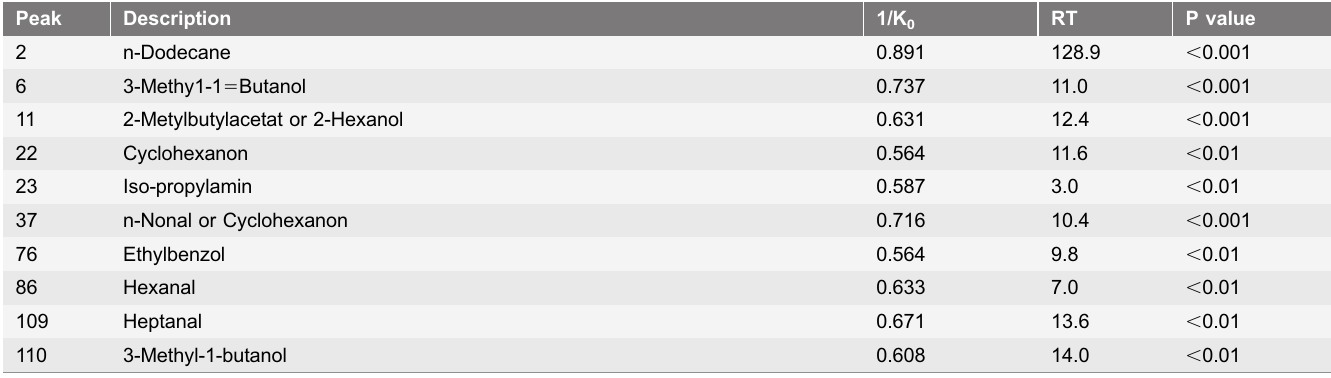
Table 3. Detection of VOC peaks using Visual Now database.